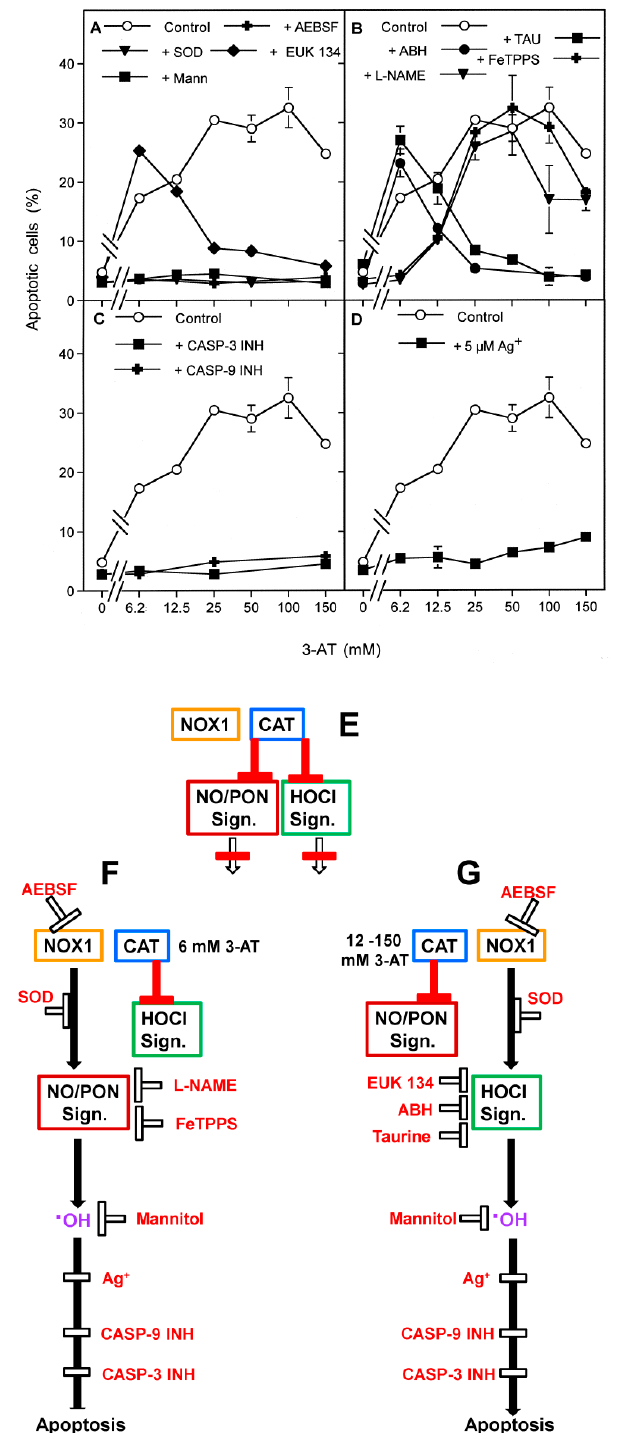
Figure 2. Intercellular apoptosis inducing signaling through the NO/peroxynitrite and the HOCl signaling pathways requires the cooperation with aquaporins. 12,500 MKN-45 cells in 96 well plates with 100 µ L complete medium received the following inhibitors/scavengers: ( A ): 100 µ M of the NOX inhibitor AEBSF, 100 U/mL MnSOD, 2 µ M of the catalase mimetic EUK-8, 10 mM of the hydroxyl radical scavenger mannitol; ( B ): 50 mM of the HOCl scavenger taurine, 150 µ M of the peroxidase inhibitor ABH, 20 µ M of the peroxynitrite decomposition catalyst FeTPPS, 2.4 mM of the NOS inhibitor L-NAME; ( C ): 50 µ M caspase-3 inhibitor, 25 µ M caspase-9 inhibitor; ( D ): 5 µ M AgNO 3